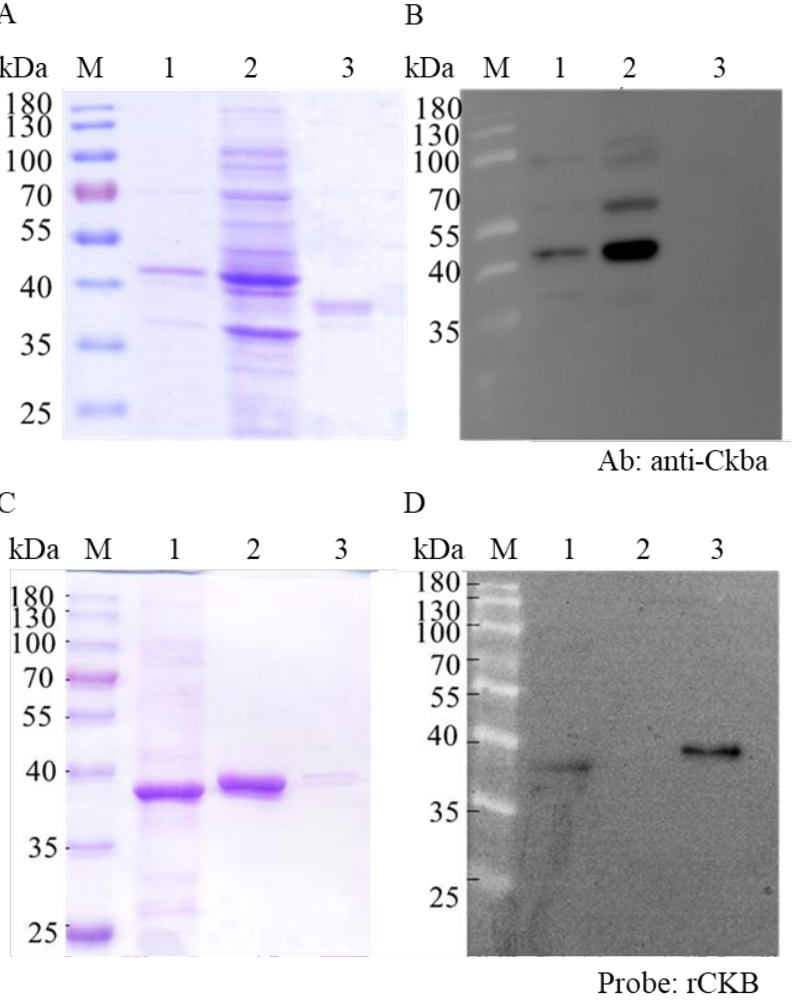
Figure 3. rCKB interacts with rNNVCP in vitro. ( A ) SDS-PAGE and ( B ) Western blotting were used to determine the recombinant CK B-type (rCKB) generated by